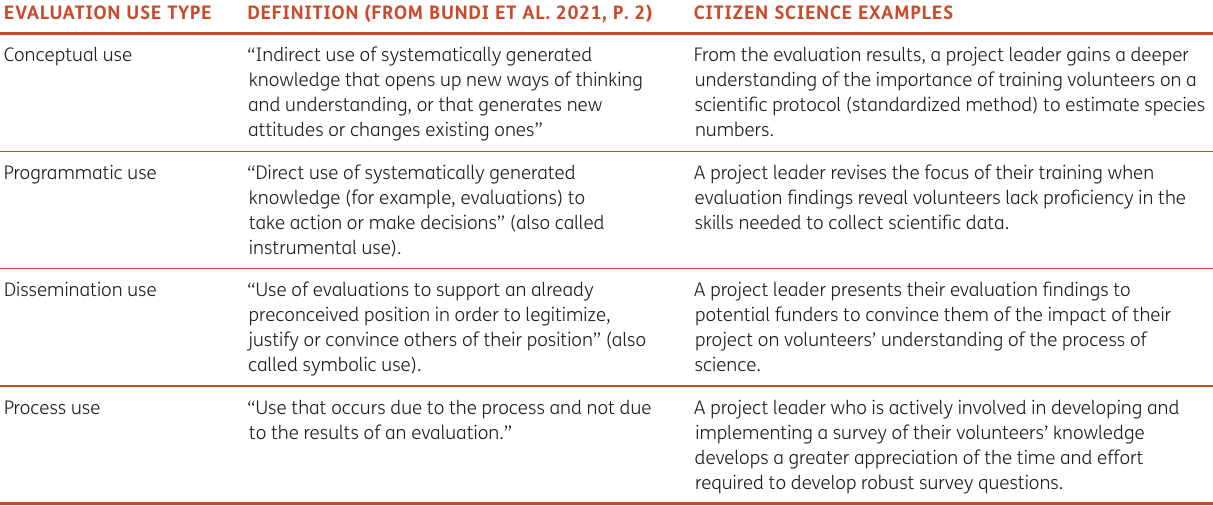
Table 1 Typology of evaluation use for citizen